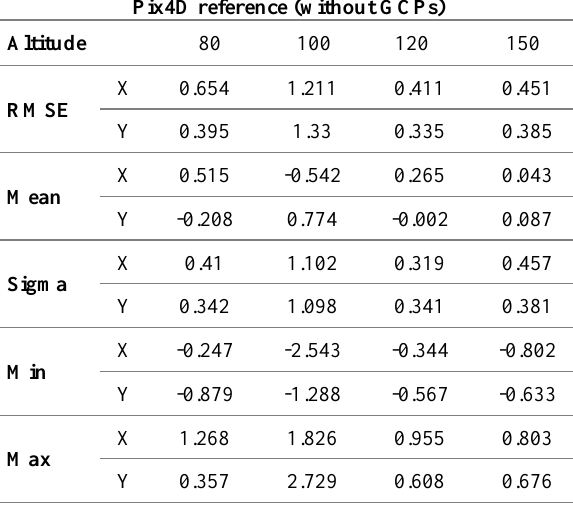
Table 7 Absolute accuracies of the orthomosaic processed with OpenVSLAM as the underlying framework. Entries in bold are the lowest RMSE among the OpenREALM results in that